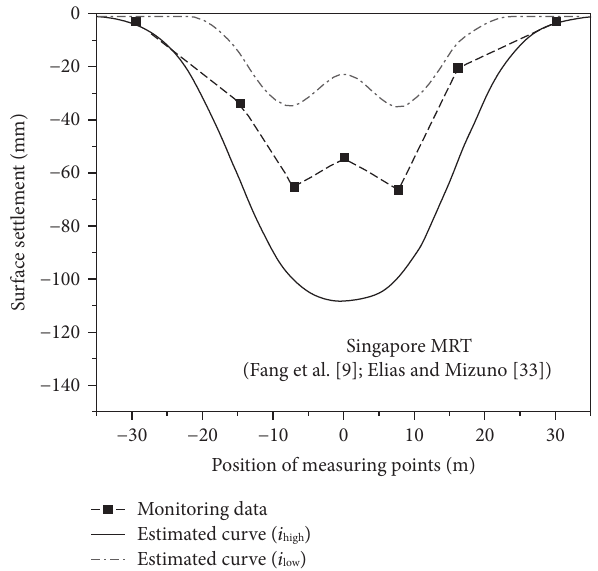
Figure 1: Monitoring data versus estimated curve of Singapore